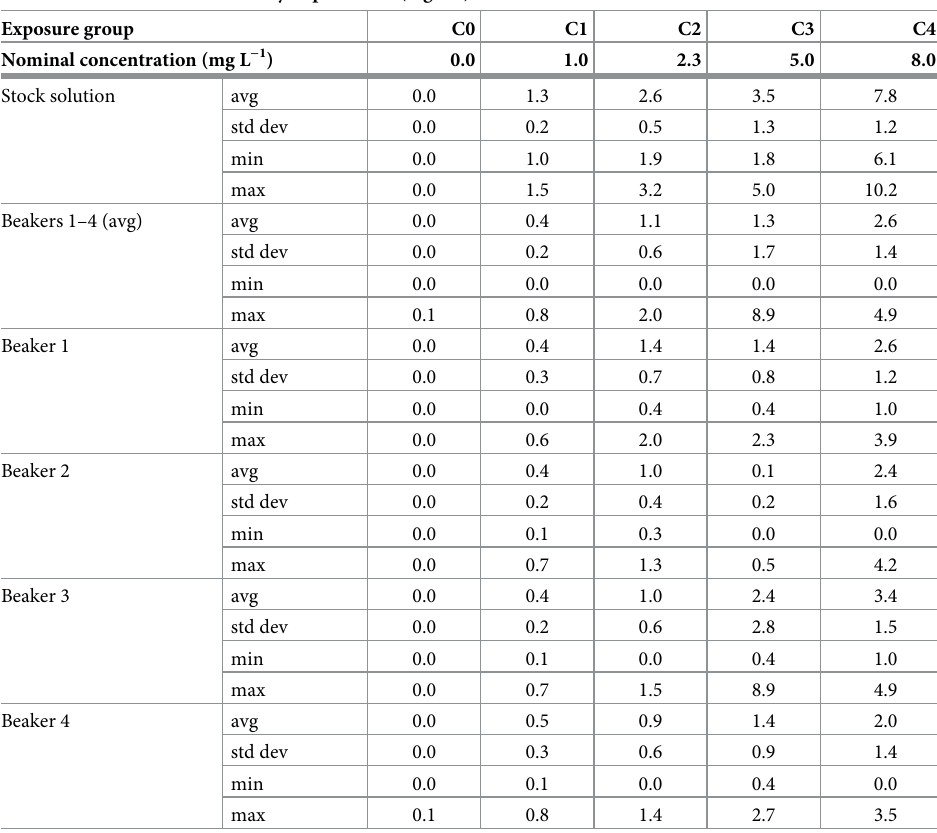
Table 2. Concentration of 2-methylnaphthalene (mg L − 1